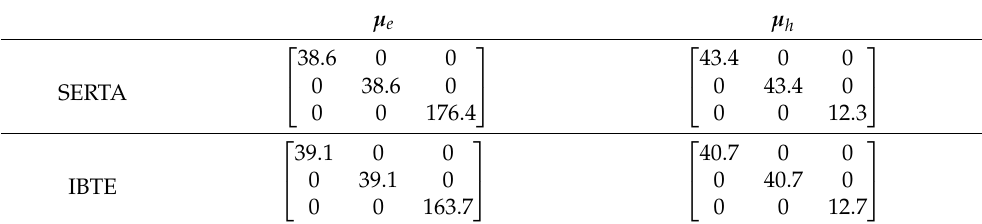
Table 3. Calculated mobility tensors of electrons ( µ e * ) and holes ( µ h * ) using the SERTA and IBTE methods.